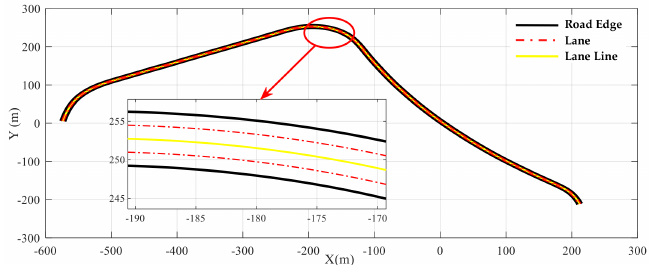
Figure 2. Geometric description of the reference road.